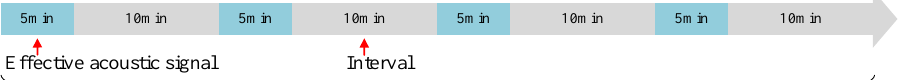
Figure 10. Layout of field verification experimental equipment.